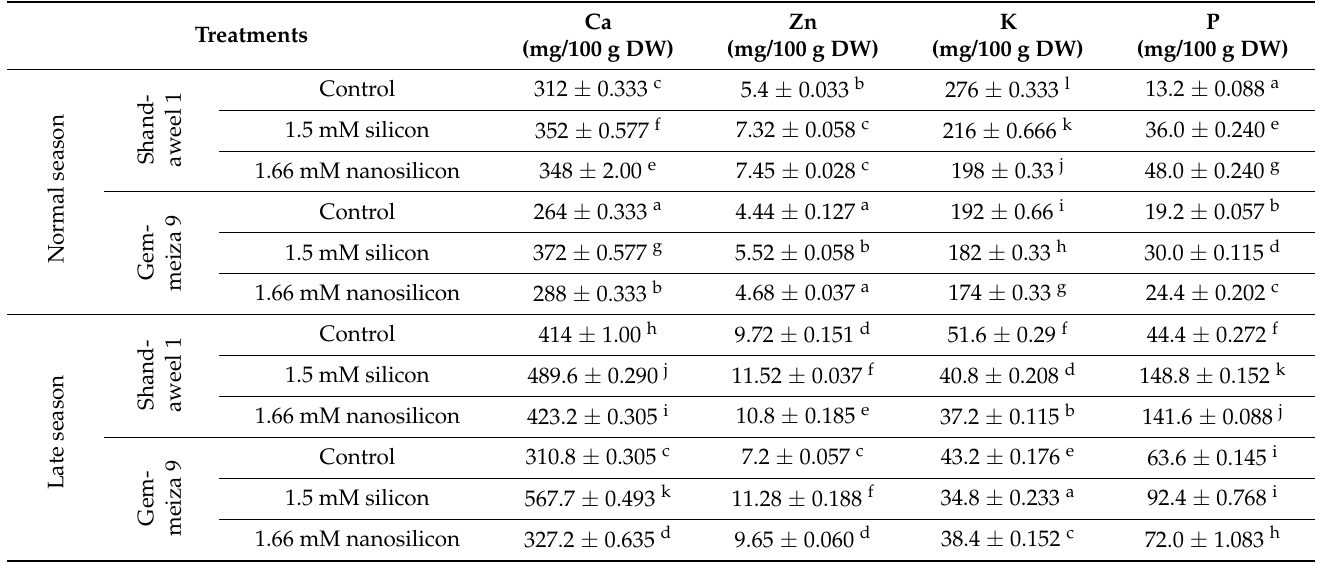
Table 5. Effects of silicon and nanosilicon on calcium (Ca), zinc (Zn), potassium (K) and phosphorous (P) in grains of two wheat cv. Shandaweel 1 and cv. Gemmeiza 9 at normal and late seasons. Each value is the main of three different replicates ± SE.